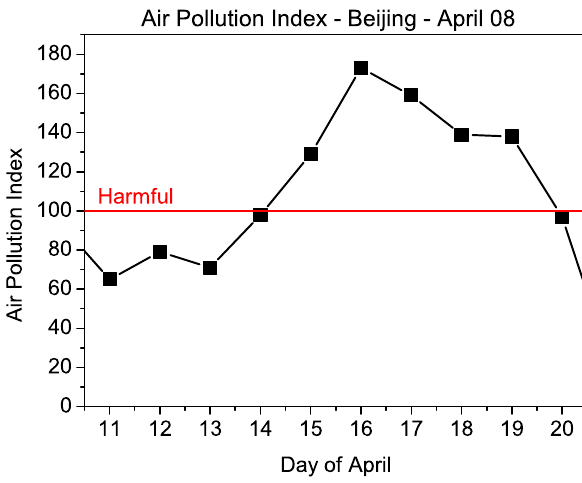
Fig. 17. Air Pollution Index (API) recorded in Beijing from 11 to 20 April